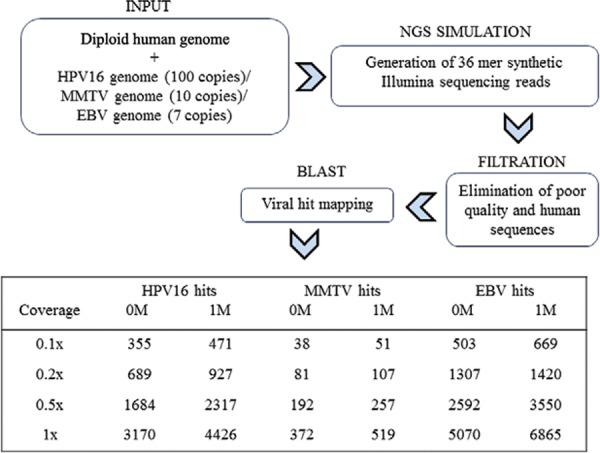
: flowchart of next-generation sequencing (NGS)
simulation. Illumina sequencing emulation generating 36 or
100 mer (not shown) reads was run in ART (Huang
et al. 2012). Different coverages were tested. Several viral hits
from human papillomavirus (HPV) 16, mouse mammary tumour virus (MMTV), and
Epstein-Barr virus (EBV) were mapped from human-viral inputs mimicking genomic
load present in tumours associated to these agents. Viral sequences were
screened allowing 0 (0M) or 1 (1M) mismatch. Tens or hundreds of viral reads
were found.